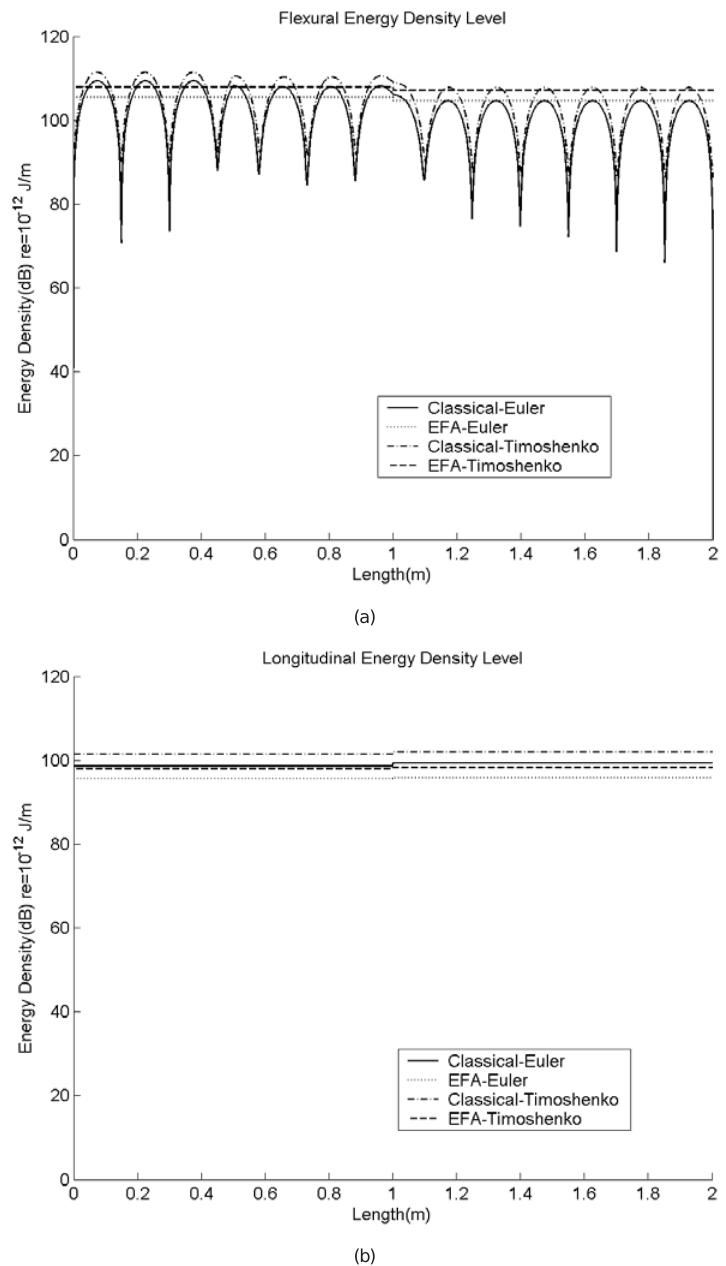
Fig. 11. The comparison of the time- and locally space-averaged energy and power levels of two Timoshenko beam with two Euler-Bernoulli beam structures coupled with θ = 45 ◦ when f = 1 kHz, η = 0 . 01 . The reference energy density is 1 × 10 − 12 J / m and the reference power is 1 × 10 − 12 W; (a) Flexural energy, (b) Longitudinal energy, (c) Flexural power, (d) Longitudinal power. at an arbitrary angle, simply supported at both ends and excited by a transverse harmonic point force as shown in Fig. 10. The dimensions of both beams are B × H × L = 0 . 01 m × 0 . 01 m × 1 m. The material properties are those (cid:25) m 3 ) . The external force is located at x L of steel ( E = 19 . 5 × 10 10 Pa, ρ = 7800 kg 0 = 1 /2 and its magnitude is 100